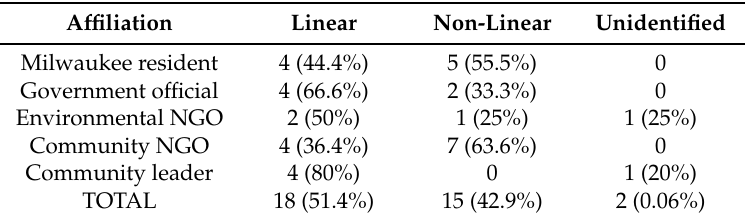
Table 3. Stakeholder affiliation and their production of injustice